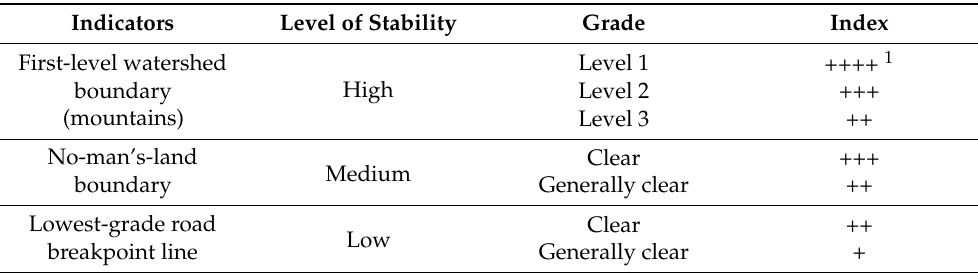
Table 3. Method to determine the stability of the (sub)dialect area